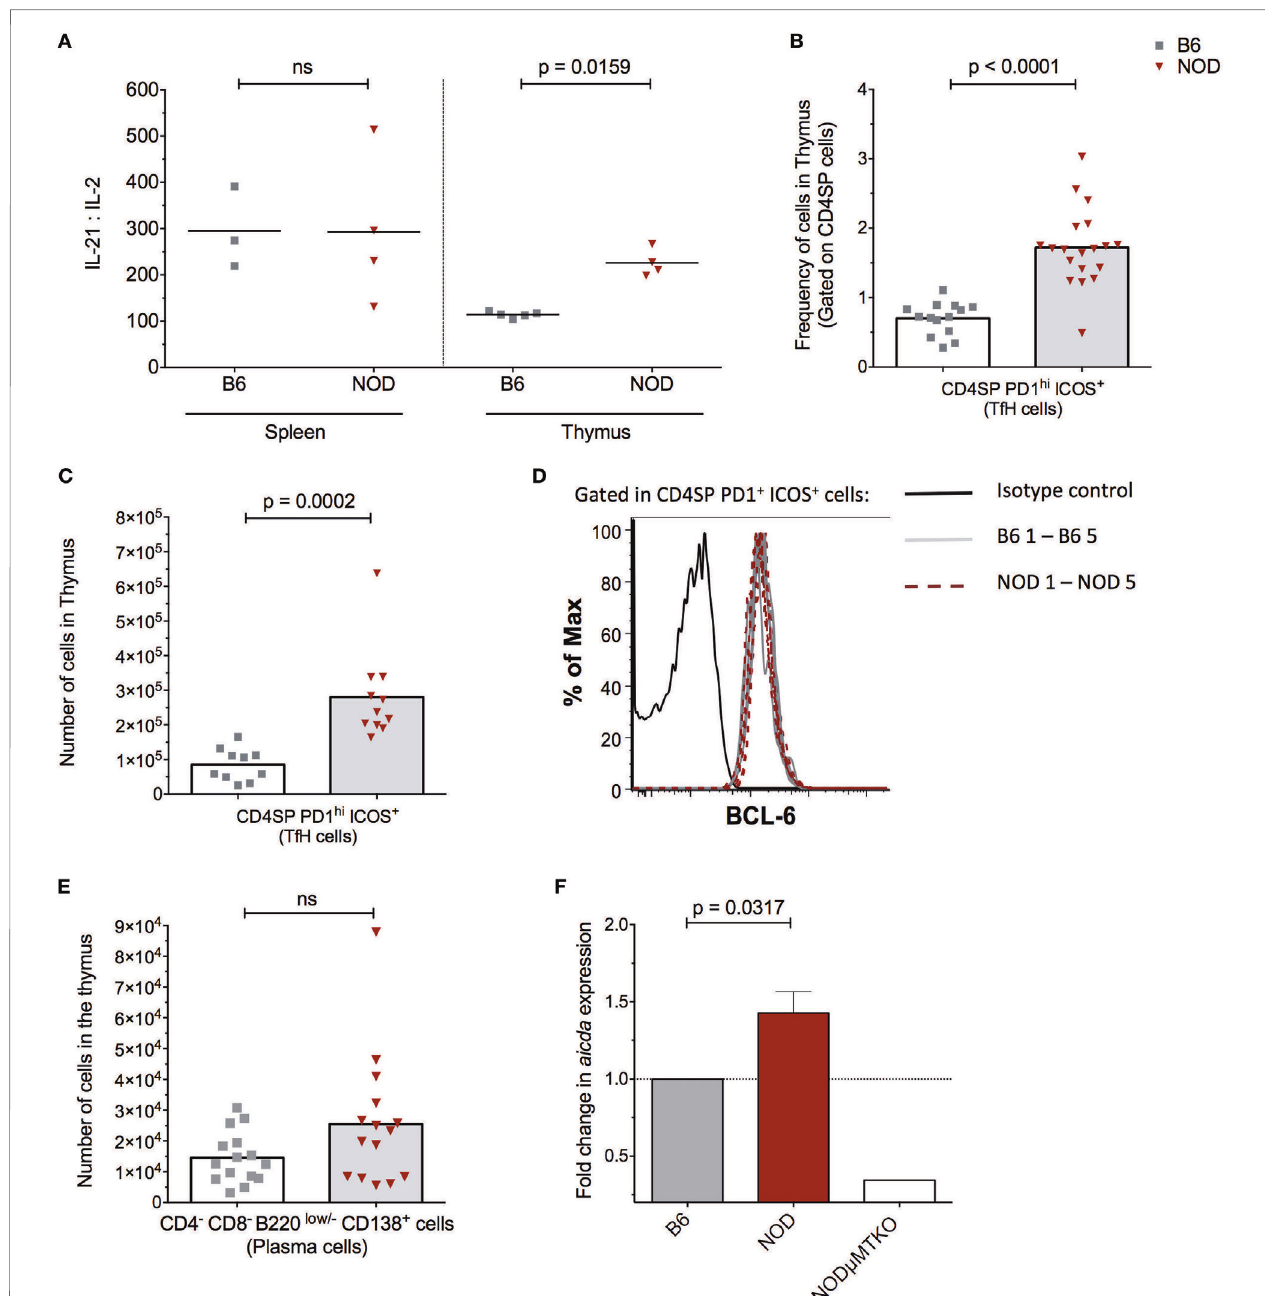
FigUre 3 | The non-obese diabetic (NOD) thymus has the hallmarks of ectopic GC development. (a) Evaluation of IL-2/IL-21 ratio in cell-free supernatants from spleen and thymic tissue from 11- to 15-week-old B6 ( n = 5) or NOD ( n = 4) mice. The data shown are representative of two individual experiments showing similar results. (B) Frequency of CD4 + T follicular helper (TfH) cells in the thymus of B6 ( n = 12) and NOD mice ( n = 17). (c) Number of CD4 + TfH cells in the thymus of B6 ( n = 10) and NOD mice ( n = 11). (D) Representative histogram of BCL-6 expression in CD8 − CD4 + PD1 hi ICOS + cells in thymus of NOD ( n = 5) and B6 ( n = 5) mice. (e) Number of plasma cells in the thymus of B6 ( n = 15) and NOD mice ( n = 15). For panels (B–e) , comparisons made between female, age-matched 10- to 14-week-old B6 and NOD mice. The analysis was performed on a single cell, live gate, and the data are presented as a scatterplot, each dot equating to a mouse, the bar represents mean value. P values were calculated using the Mann–Whitney U -test analysis and are shown in this figure; ns, not significant. The data are pooled from at least two independent experiments giving similar results. (F) Quantitative-PCR analysis of activation-induced cytidine deaminase (AID) mRNA ( aicda expression) levels in the whole thymus. Data were normalized to HPRT mRNA as described in Section “Materials and Methods,” and fold change in NOD mice AID mRNA when compared with normalized AID mRNA levels for B6 mice. All mice were 11–14 weeks of age, a total of five female B6 mice were compared with five female NOD mice. One thymic sample from a female B cell-deficient NOD μ MT − / − mouse was used as a negative control. The data are pooled from two independent experiments and are presented mean ± SEM. P values were calculated using the Mann–Whitney U -test and are shown in this figure; ns, not